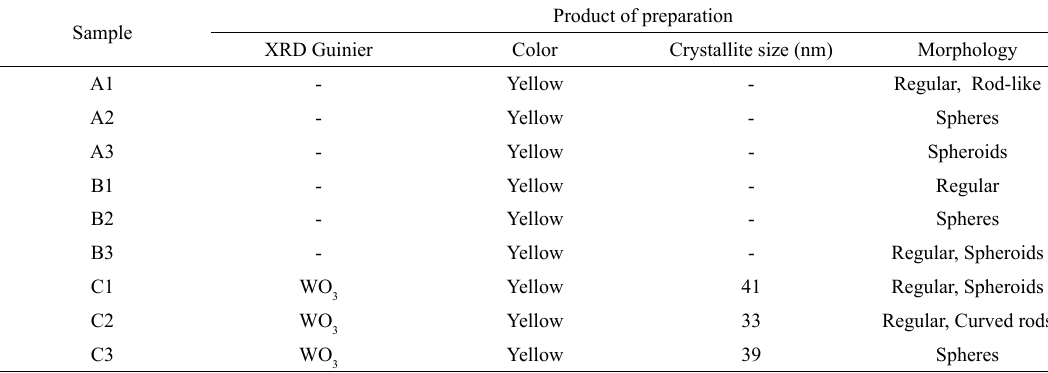
Figure 5. XRD patterns of WO 550ºC for 90 min with different amounts of oxalic acid and PEG. All peaks match with the standard pattern of monoclinic WO (JCPDS # 83-0950). Table 2. Characterization of the product under various conditions